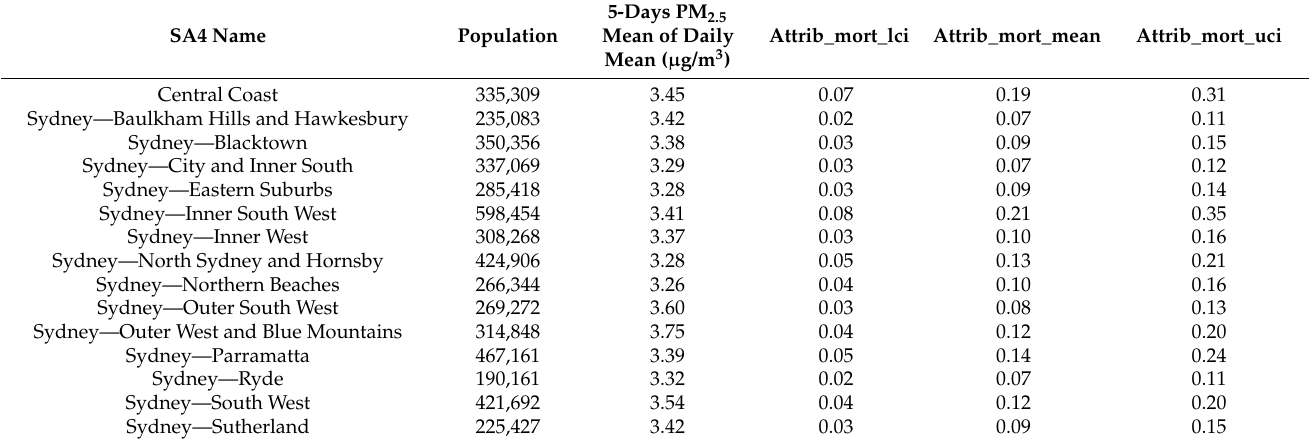
Table 1. Impact of dust storm from 11 to 15 February 2019 on mortality in each of the SA4 regions in the NSW. The units are number of persons except for PM 2.5 the unit is µ g/m 3 (*) the value designates the average over all SA4 regions of the 5-days PM 2.5 mean of daily